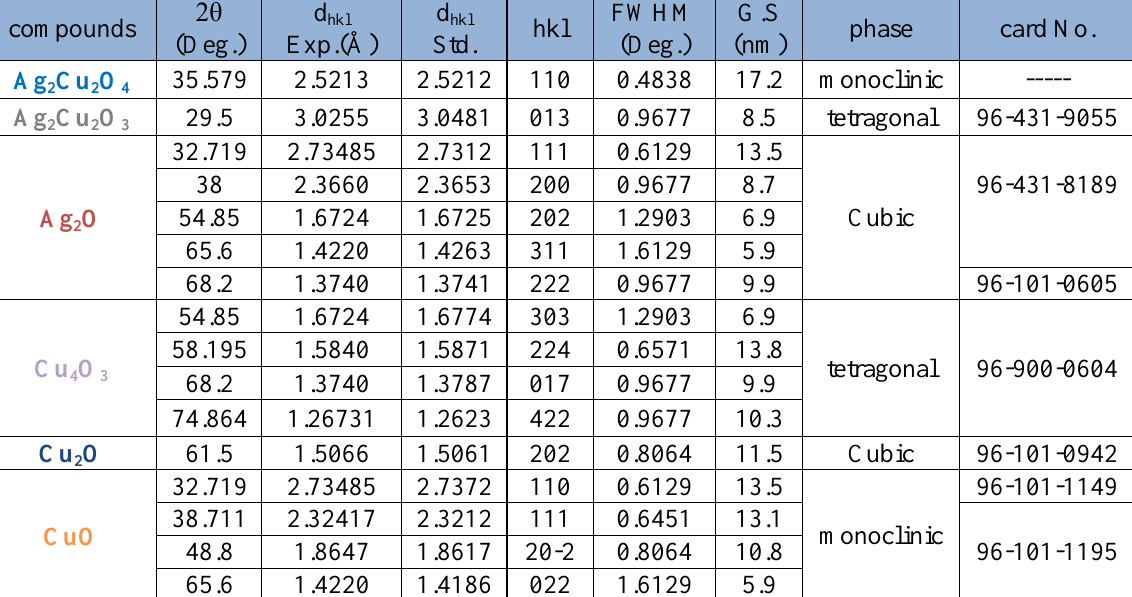
Table 1: Structural parameters viz. inter-planar spacing, crystallite size and miller indices of Ag Cu O powder at sintered at 200 °C. 2 2 4 compounds